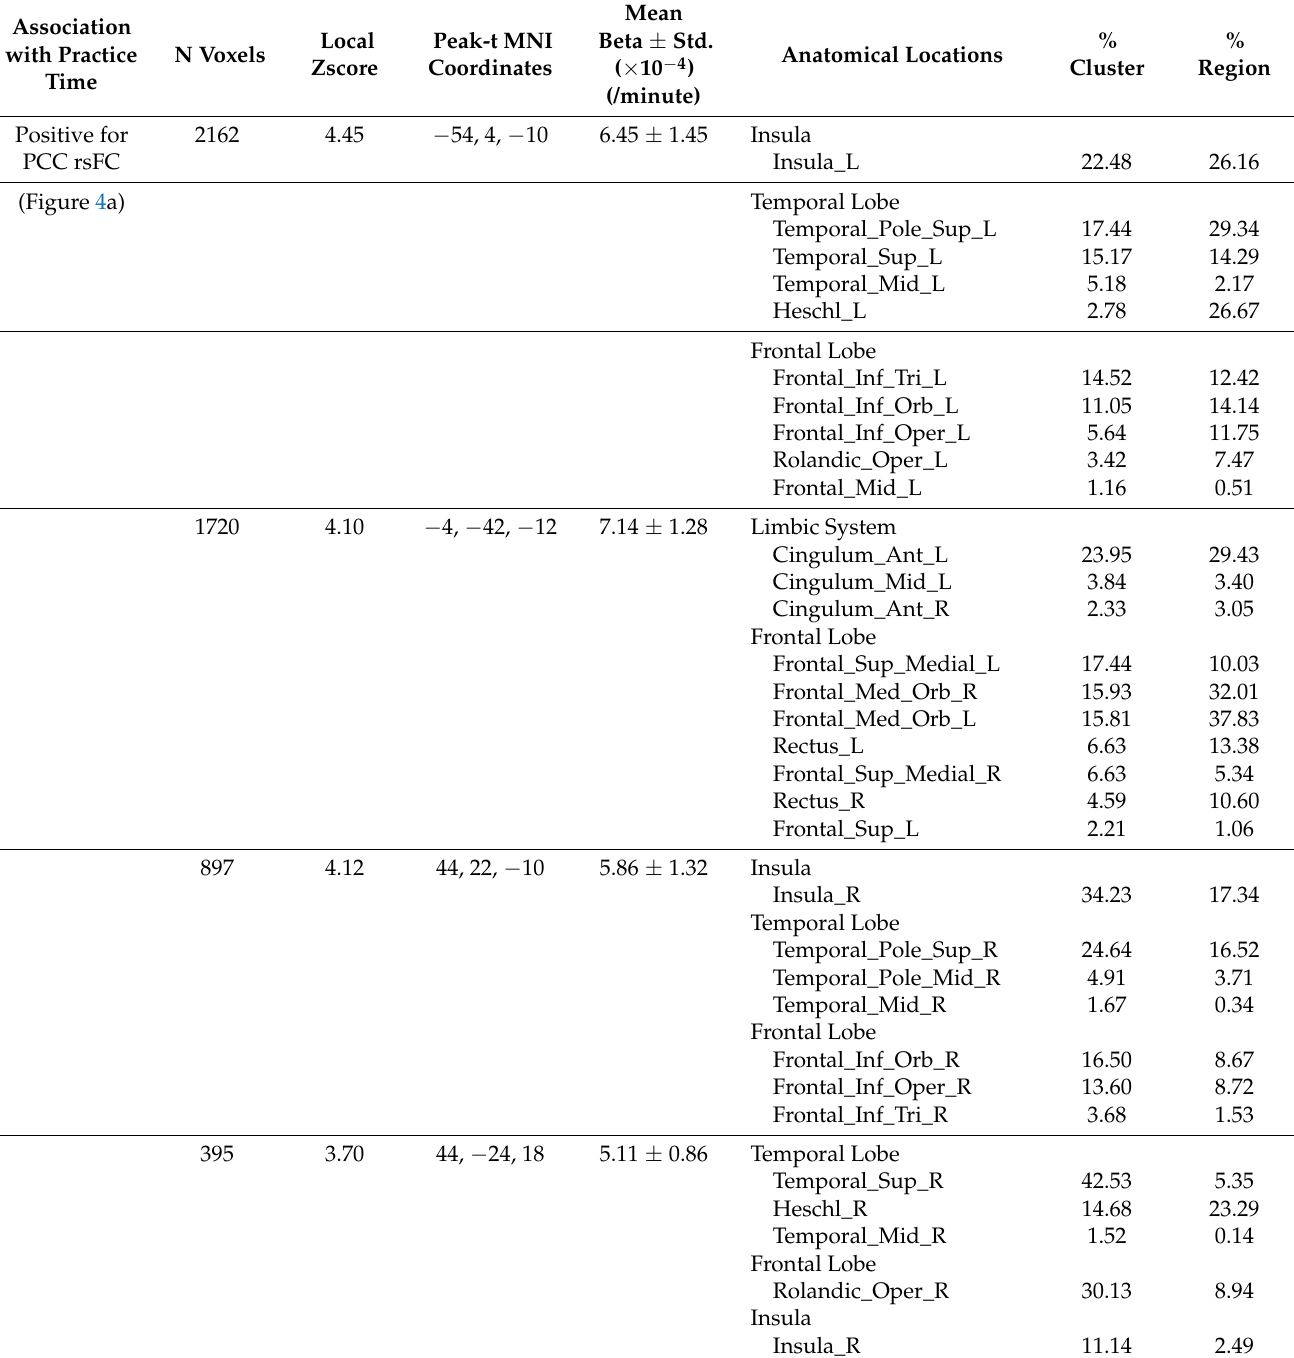
Table 3. Summary of cluster-level statistics for clusters showing significant longitudinal FC changes associated with meditation practice